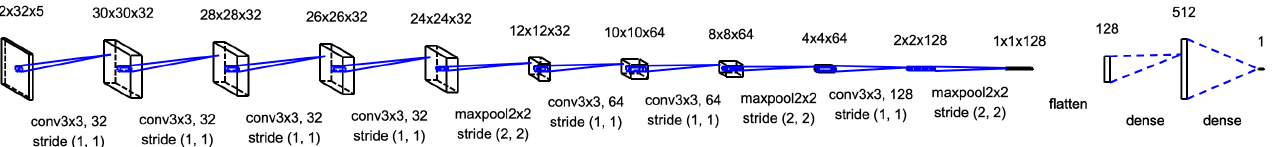
Figure 4. Single VGGNET-inspired Convolutional Neural Network (CNN) architecture for feature maps learning with spectral topology-preserving head-maps with brain rate as a target